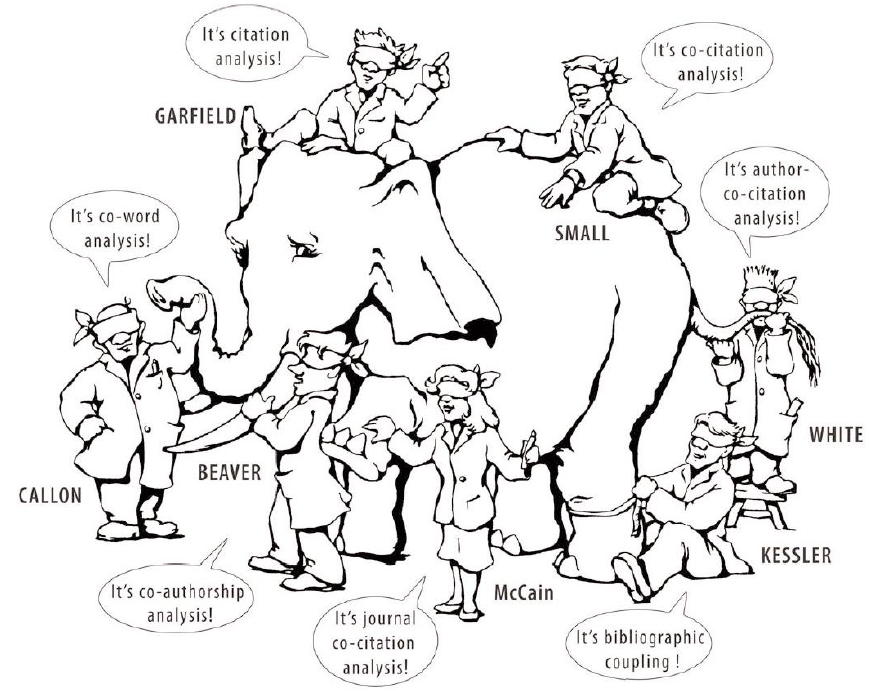
Figure 2. Methods applied in the scientometric analysis [49].